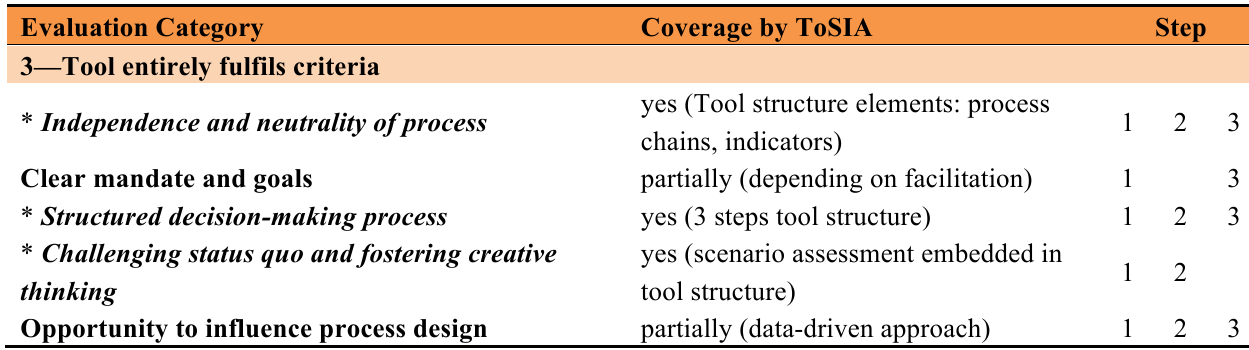
Table 3. List of pDSS evaluation criteria categorised according to level of influence